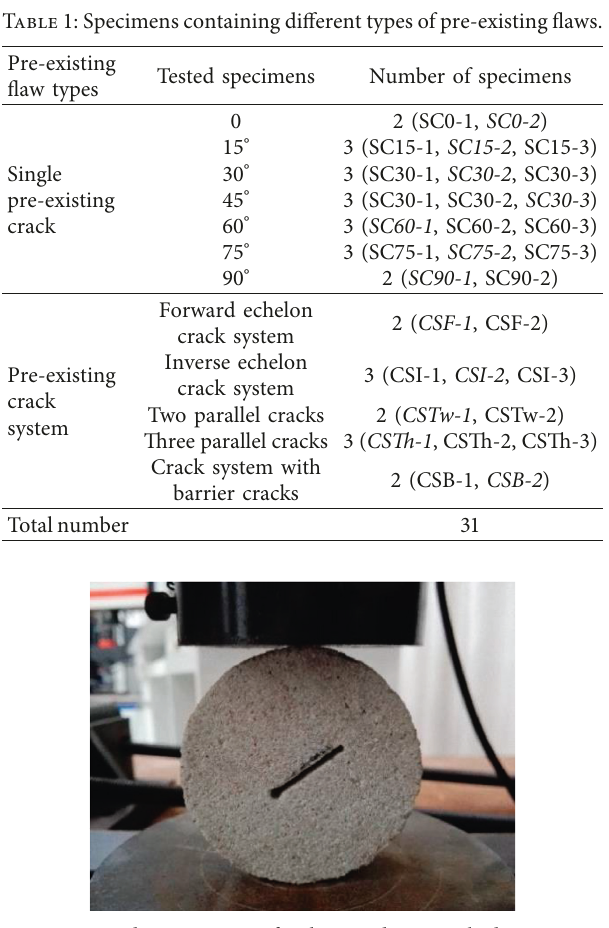
Figure 7: Load arrangements for the tested pre-cracked